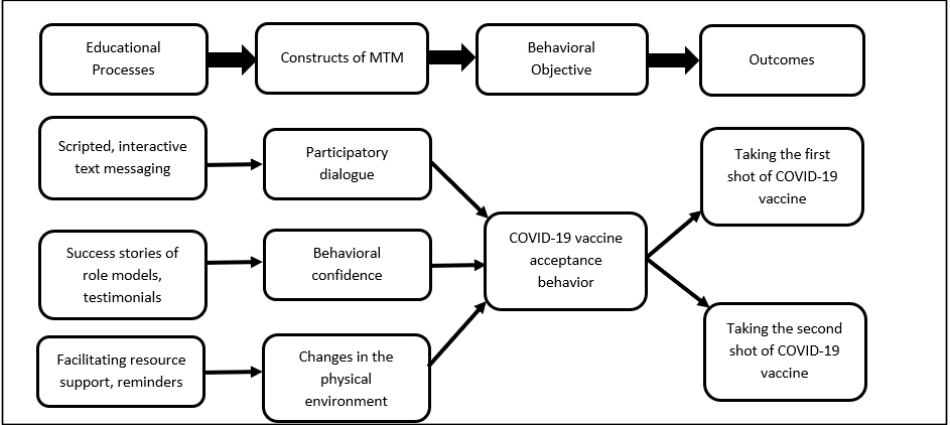
Figure 3. Diagrammatic depiction of how the multi-theory model (MTM) for health behavior change can be used to improve the COVID-19 vaccine uptake behavior through an m-health intervention.